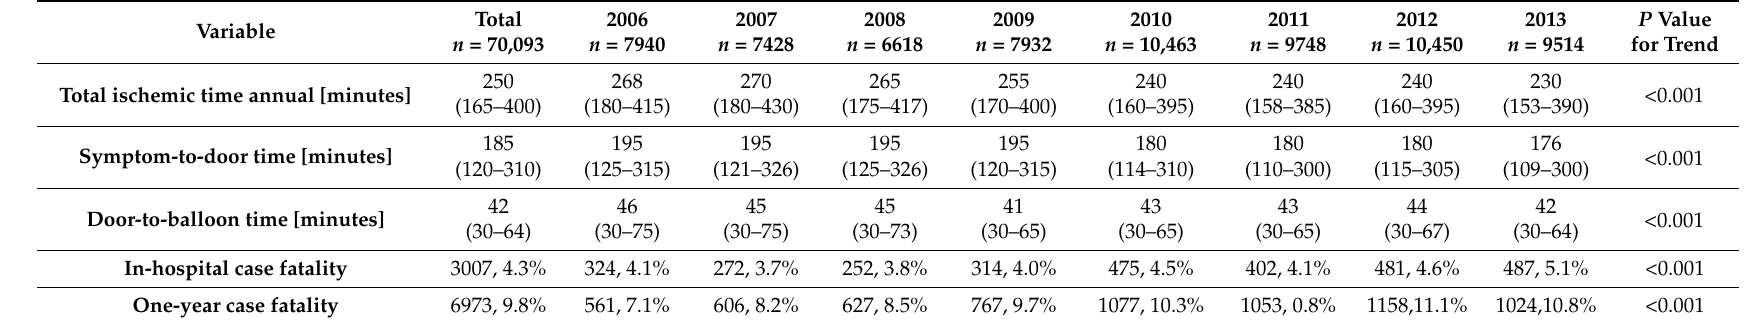
Table 2. Temporal trends in time intervals and fatalities